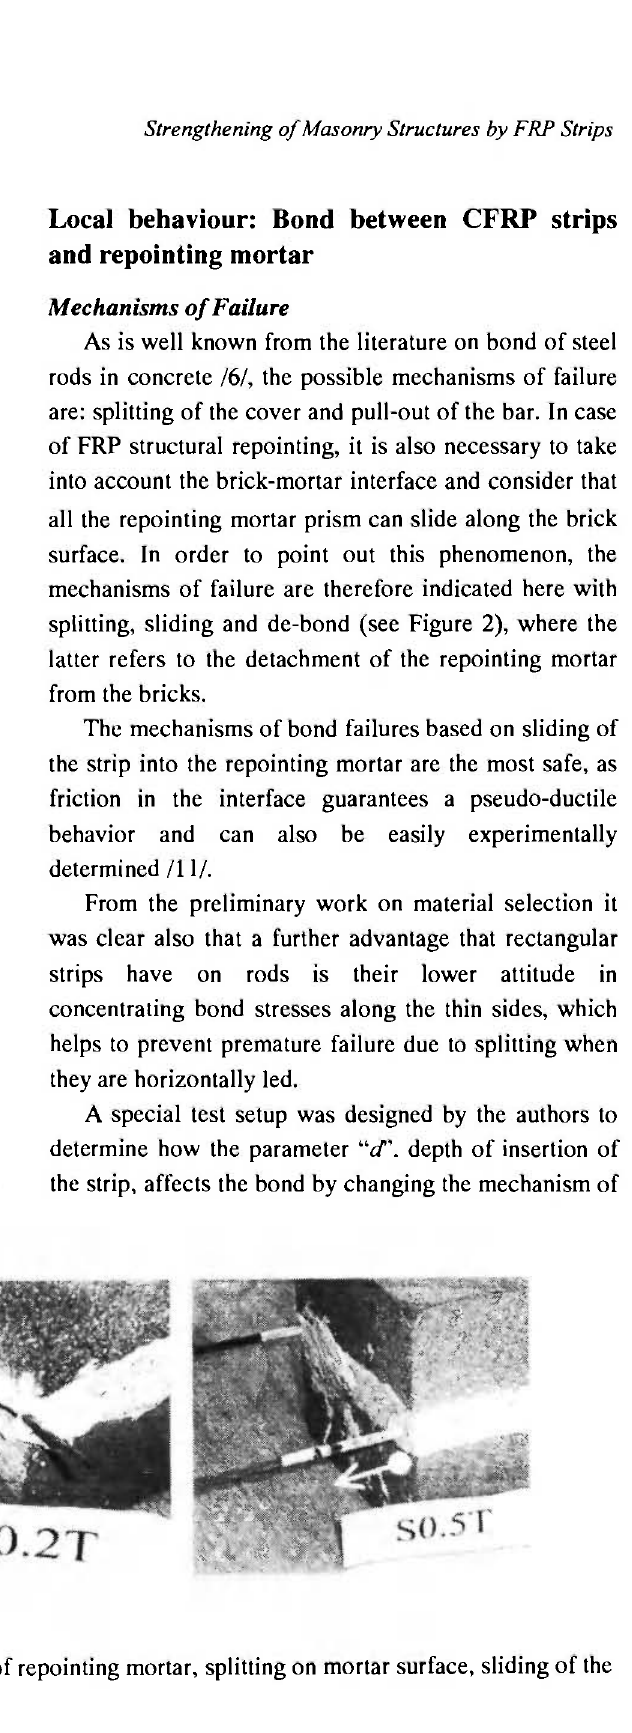
Different mechanisms of bond failures: de-bond of repointing mortar, splitting on mortar surface, sliding of the strip into the repointing